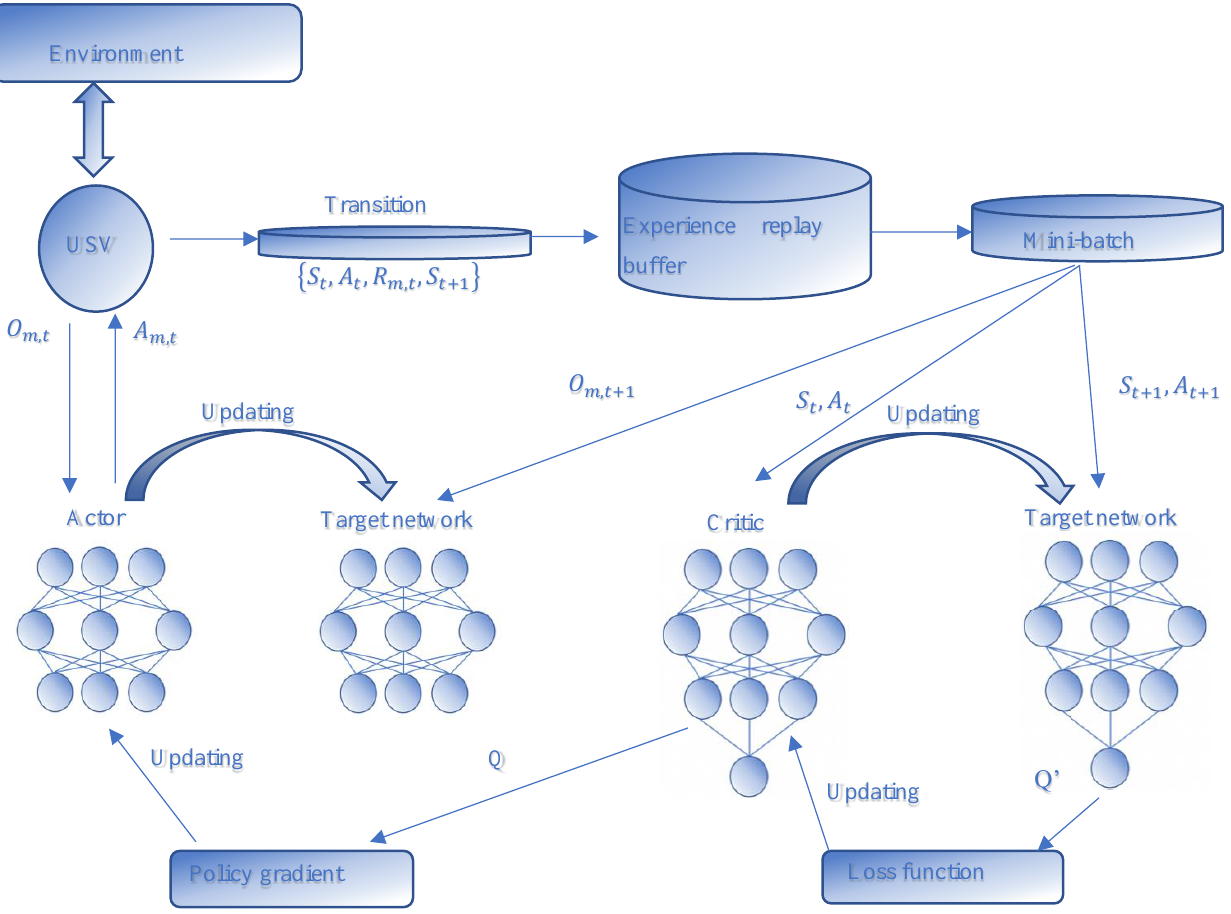
Figure 2. The framework of MADDPG for the cooperative multi-USV network. State: The state of any agent is a one-dimensional vector with five components, x, y, d U , d O , d T . The first two elements represent the current 2D position of the agent, the third entry d U represents the distance between agents, and the fourth entry d O represents the distance between agent i and the surrounding obstacles. The fifth element T d represents the distance from agent i to the current matching target which can be changed with the changes in the USV ’ s selection.